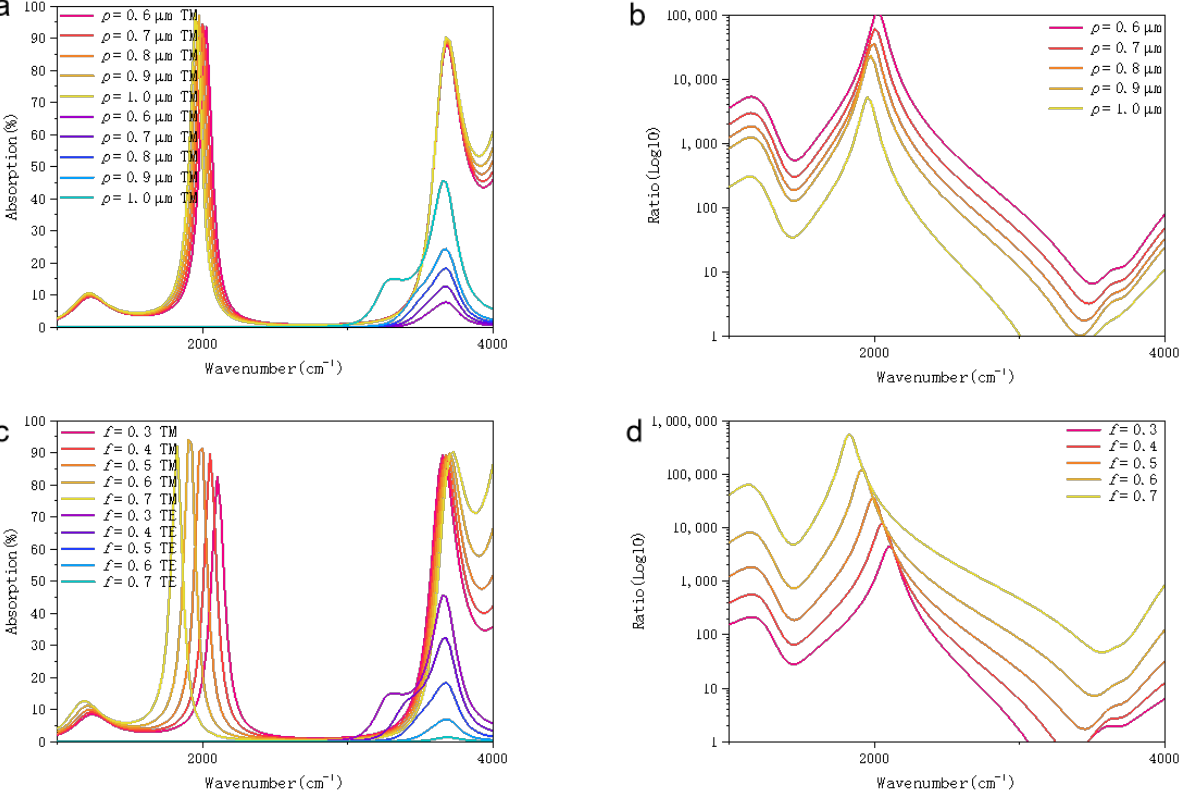
Figure 3. ( a ) Influence of different periods on polarization performance and absorption rate in mid- wave region. ( b ) Extinction ratio for different periods in mid-wave region. The thickness of metal wire grid is 100 nm. Duty cycle f is 0.5. The thickness of SiO 2 is 700 nm. The thickness Si is 280 nm. ( c ) Influence of different duty cycle on polarization performance and absorption rate in mid-wave region. ( d ) Extinction ratio for different duty cycle in mid-wave region. The thickness of the metal wire grid is 100 nm. The period p is 0.8 μm. The thickness of SiO 2 is 700 nm. The thickness of Si is 280 nm.